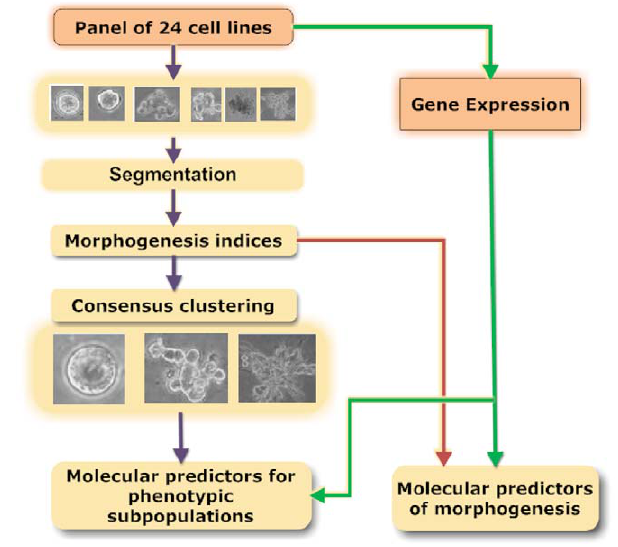
Figure 1. Computational pipeline for differential and associa- tion studies between colony morphologies and gene profiles for the panel of breast cancer cell lines cultured in 3D.